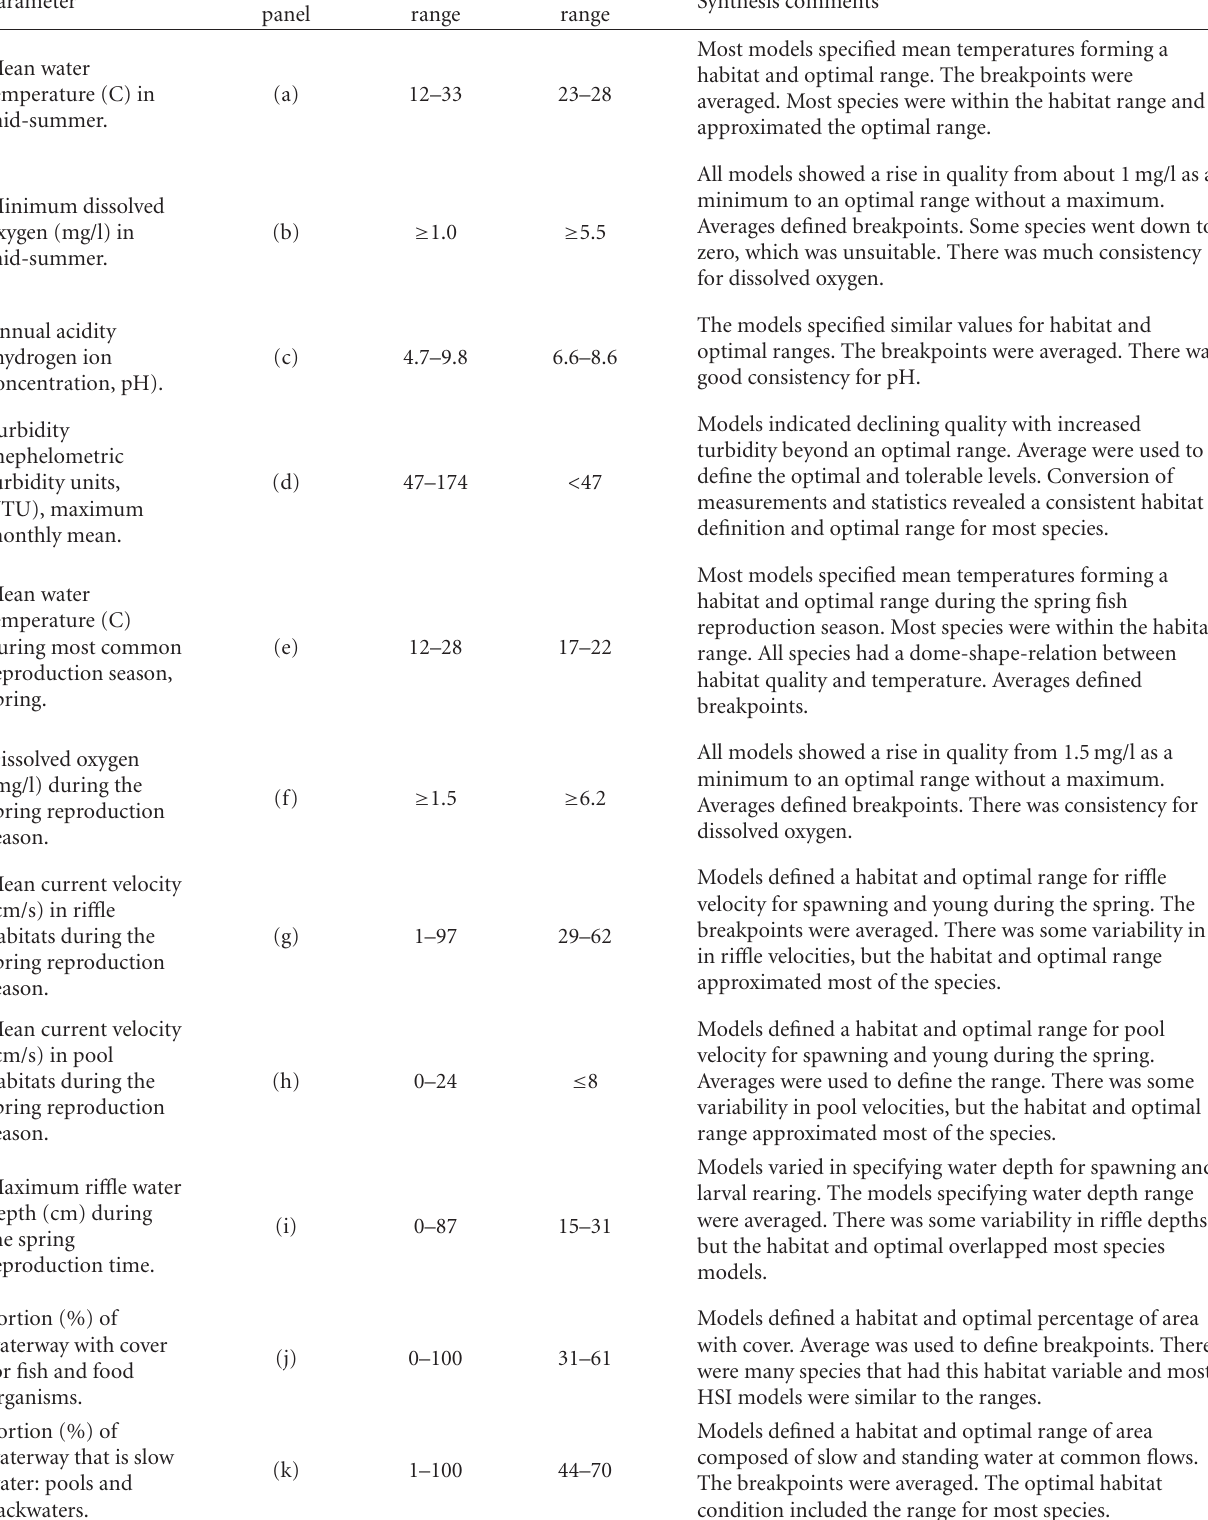
Table 2: Habitat definitions and optimal ranges for 11 variables that serve as specifications for rehabilitating streams and small rivers. The manner that species model variables were consolidated and the key to plots are provided in Figure